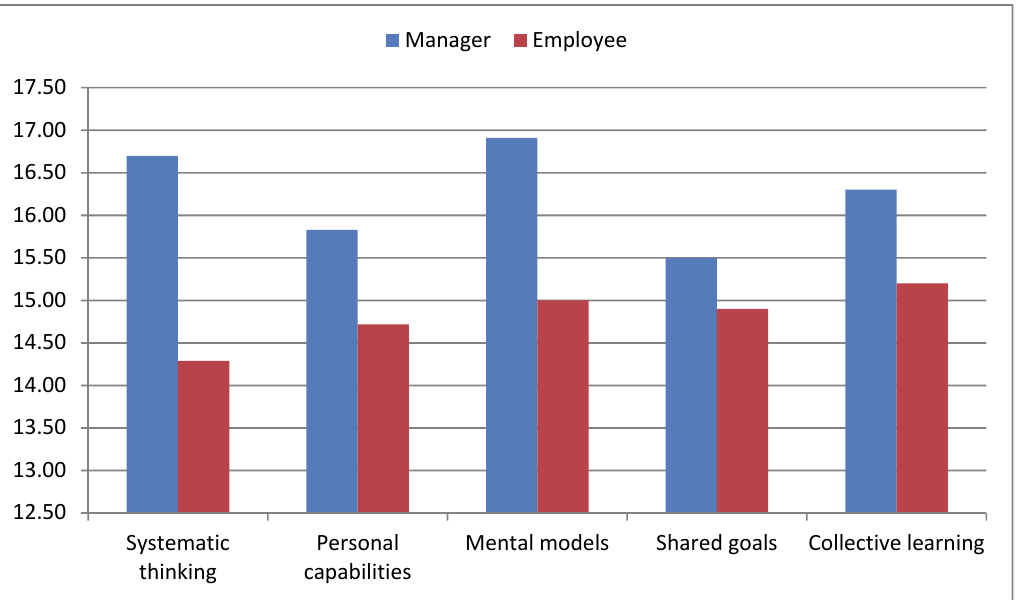
Fig. 2. The summary of mean of